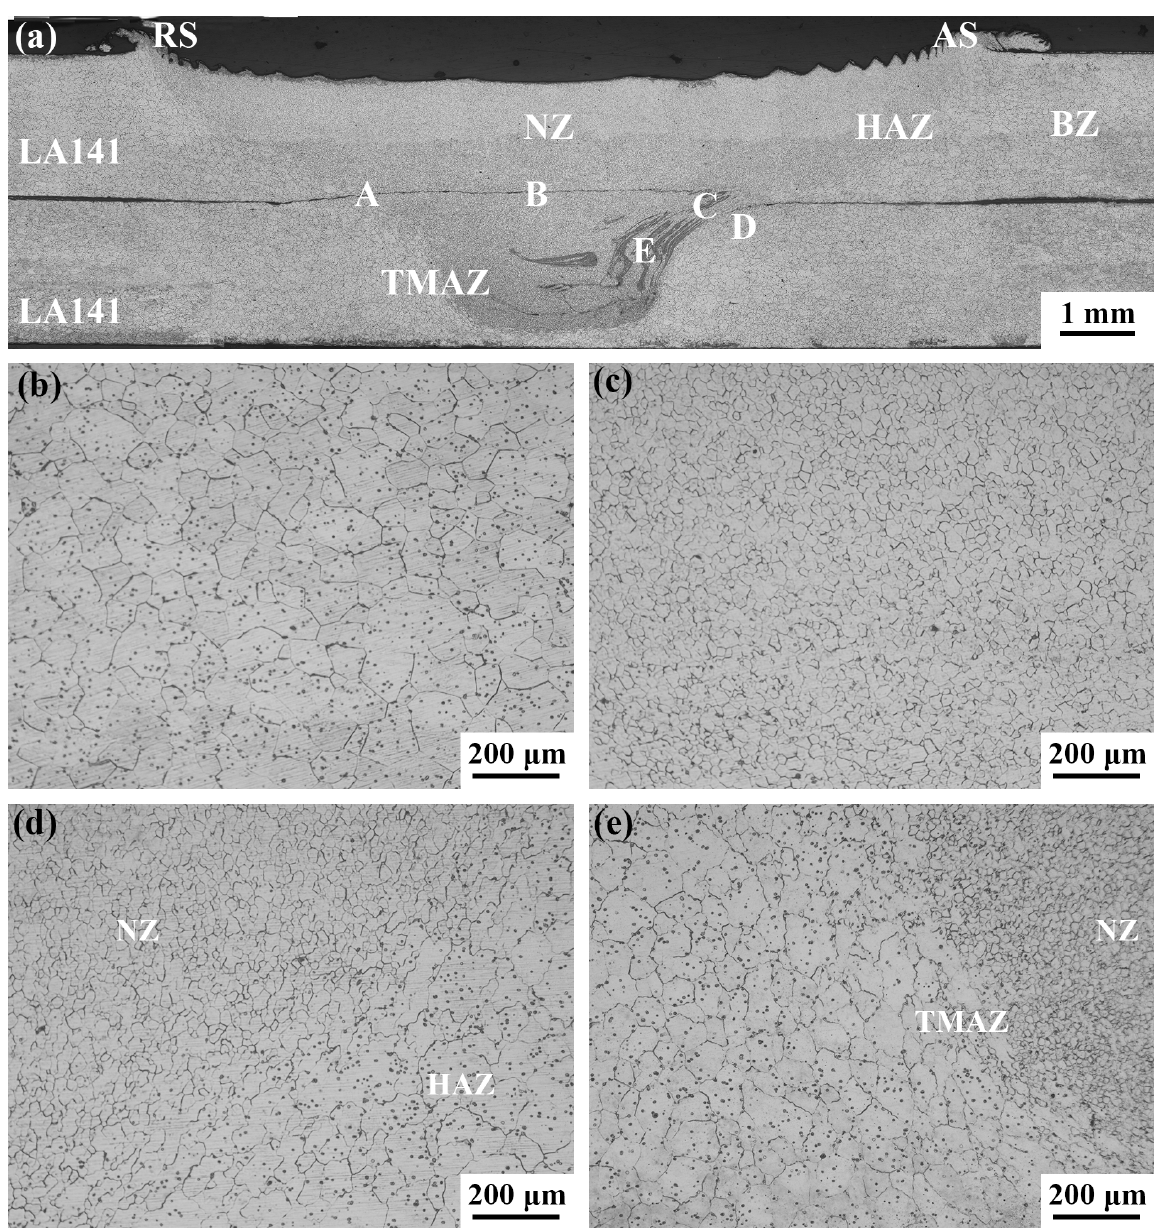
Figure 3: (a) Typical cross-section photograph of the LA141/LA141 lap joint and the microstructures of (b) BZ, (c) NZ, (d) HAZ and (e)